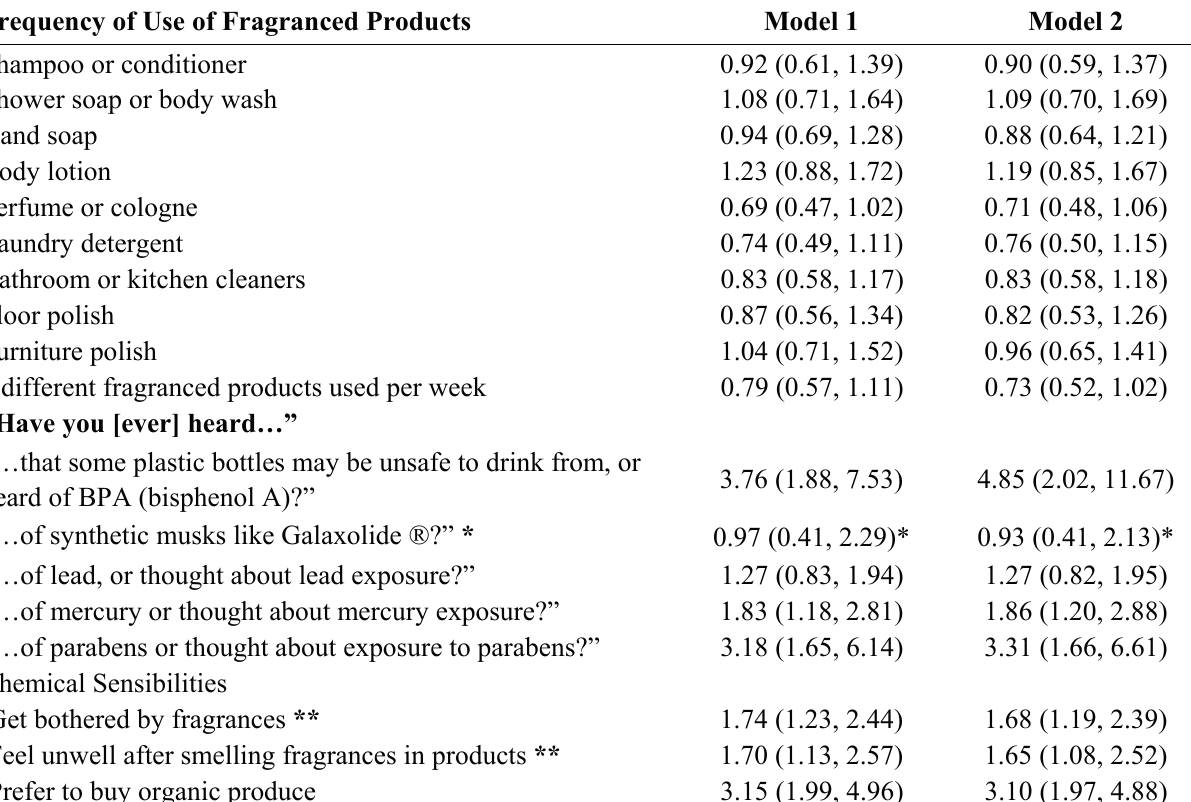
Table 3. Associations of “thinking about risks” with frequency use of fragranced products and with exposure awareness among white participants ( N = 280). Models are ordered logistic regressions with random intercepts for twin pair and address (Model 1) or with further adjustment for sex, age, education, and ever being bothered by fragrance * (Model 2). Missing data were imputed by multiple imputation with chained